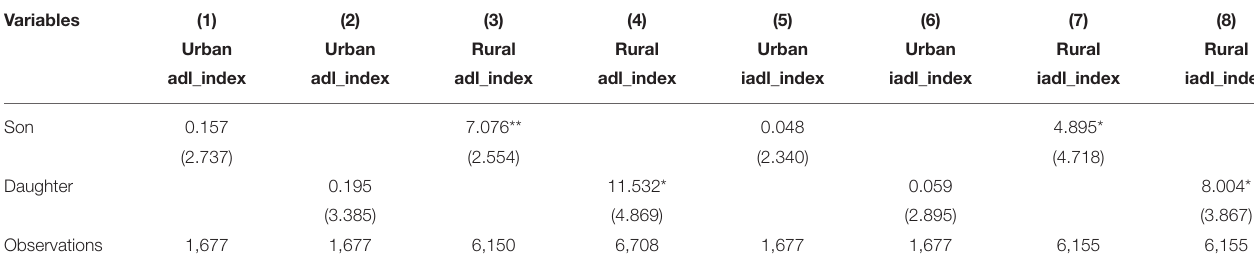
TABLE 8 | The robustness check